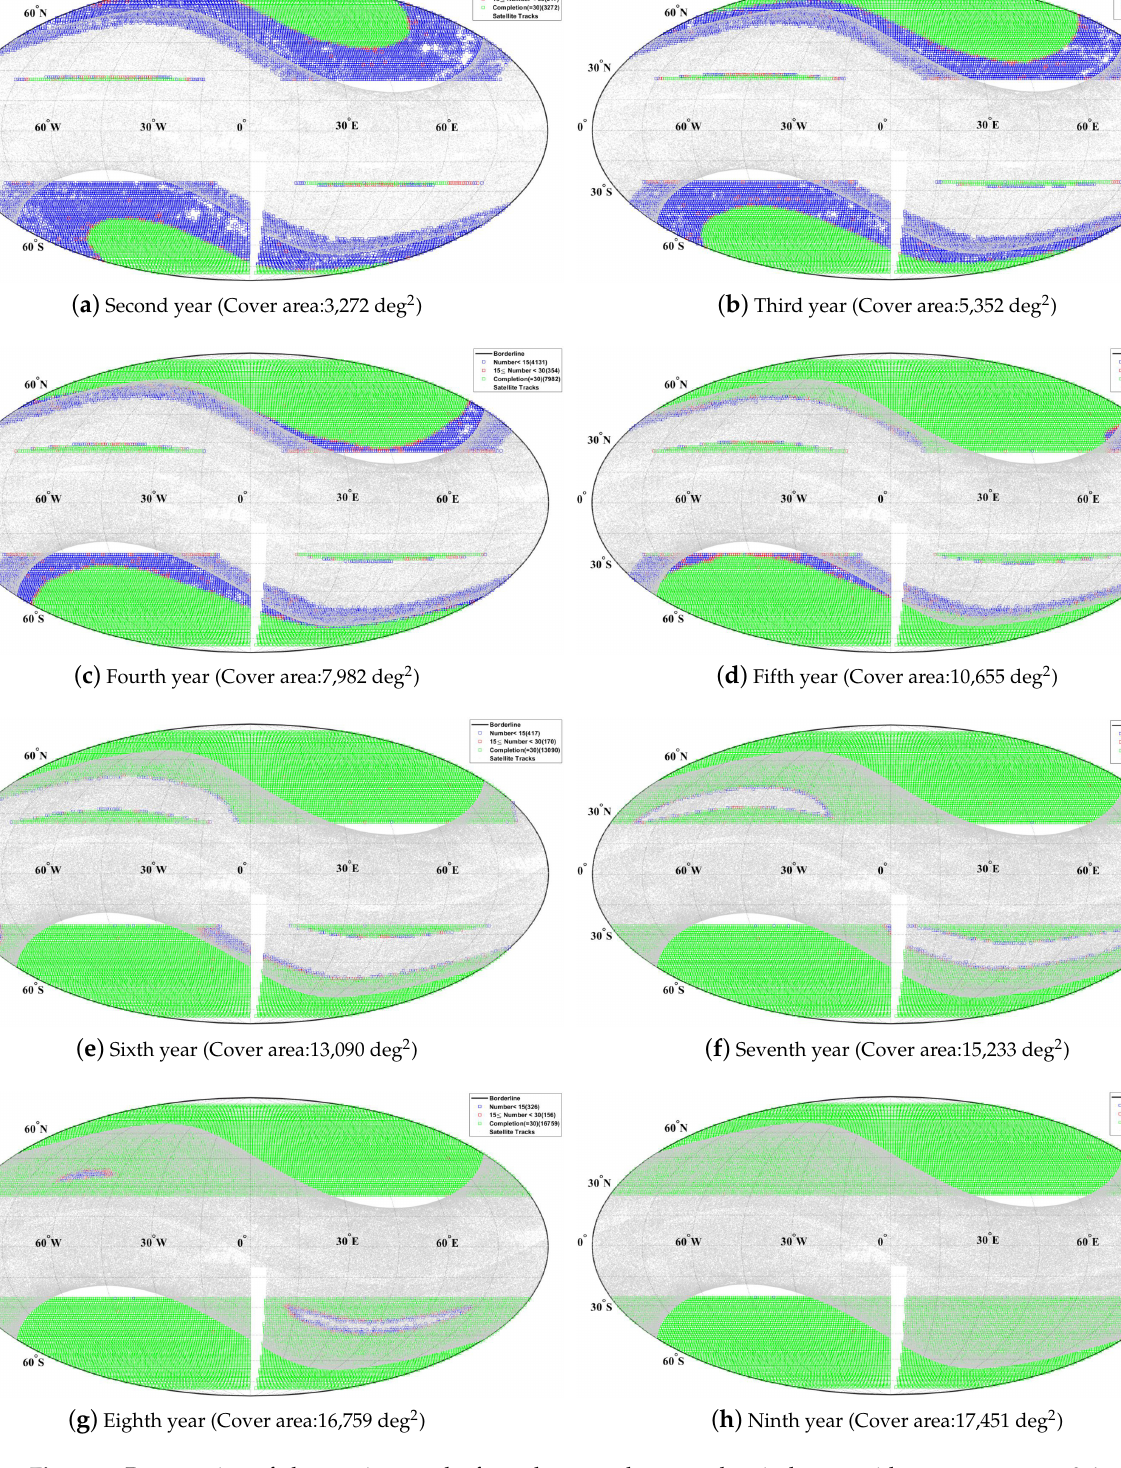
Figure 9. Presentation of observation results from the second year to the ninth year with parameter γ 1 =